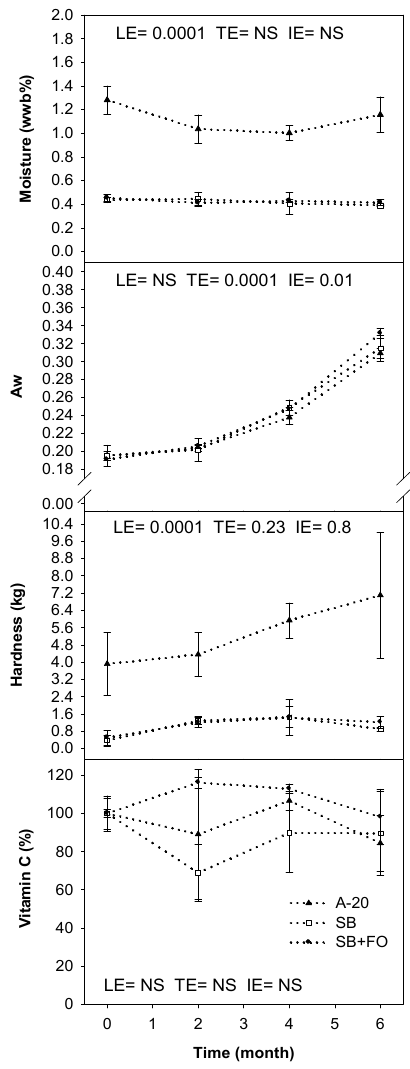
Figure 3. Changes in several chemical and physical parameters in LNS products over six months of storage at 40 °C. Data points represent means ±SD. Factors effects due to LNS (LE), time (TE) and their interaction (IE) were evaluated using repeated measures ANOVA and post hoc mean tests (Tukey HSD). Statistical differences were deemed significant at the level of p < 0.05. Non-significant (NS) p -values were not included.